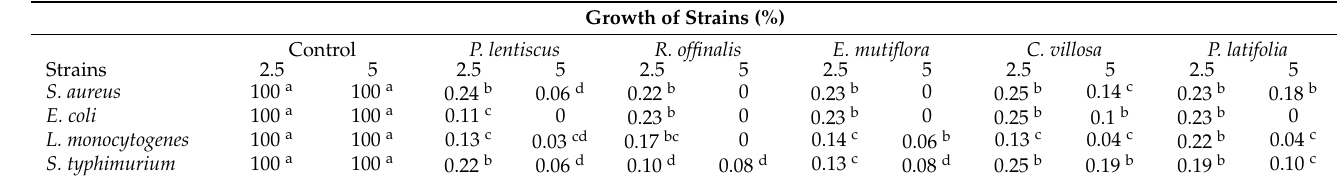
The values of OD620 at different times shown in this table were the mean of three replicates with mean standard ± SD (n = 3). Significant differences ( p < 0.05) were indicated by the values with different exponents in the same line (a–d). Table 4. Percentage of Escherichia coli , Salmonella typhimurium , Listeria monocytogenes , and Staphylococ- cus aureus cells that can develop colonies on NA, NA supplemented with 2.5% and 5% of NaCl after 30 min of treatment with MICs of Pistacia lentiscus , Rosmarinus officinalis , Erica multiflora , Calicotome villosa , and Phillyrea latifolia